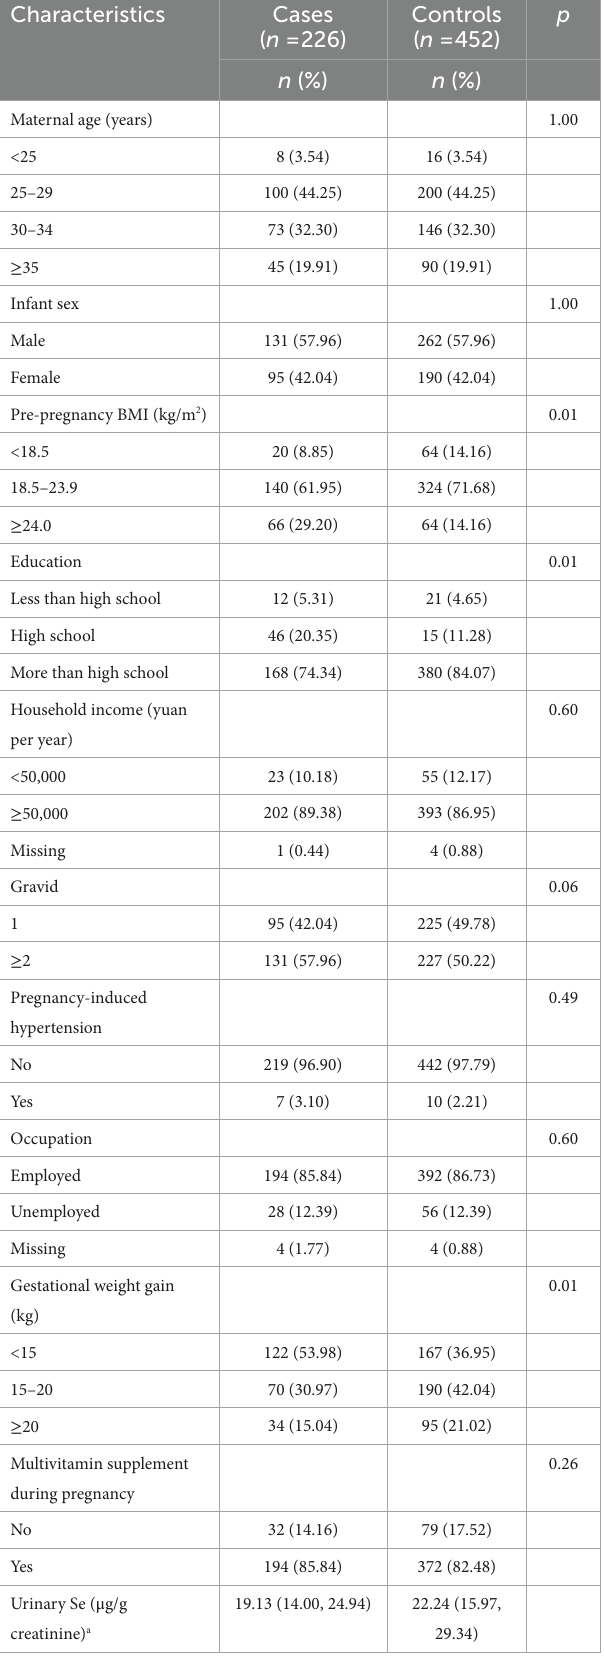
TABLE 1 Basic characteristics of GDM cases and controls. TABLE 2 Association between maternal urinary Se levels and GDM